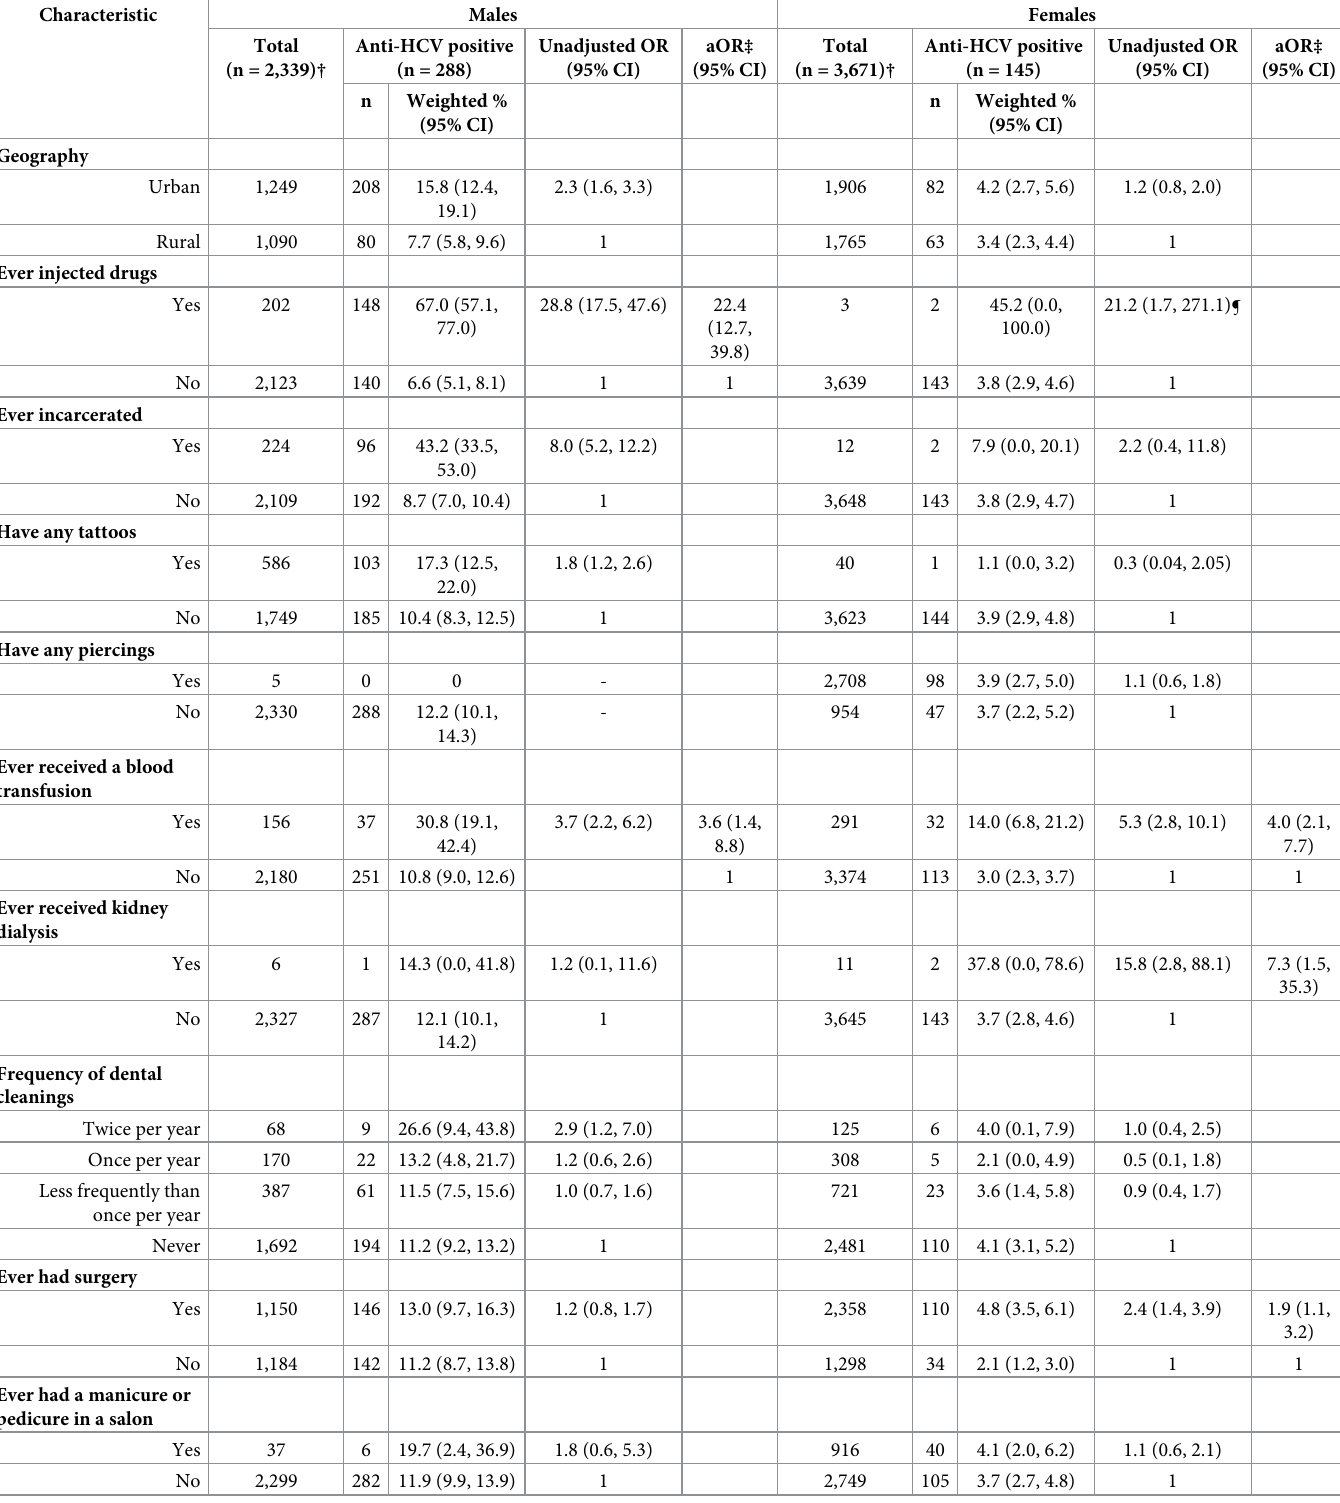
Table 1. Descriptive statistics and results of unadjusted and adjusted analyses of anti-HCV risk factors, stratified by sex, Georgia HCV serosurvey, 2015.